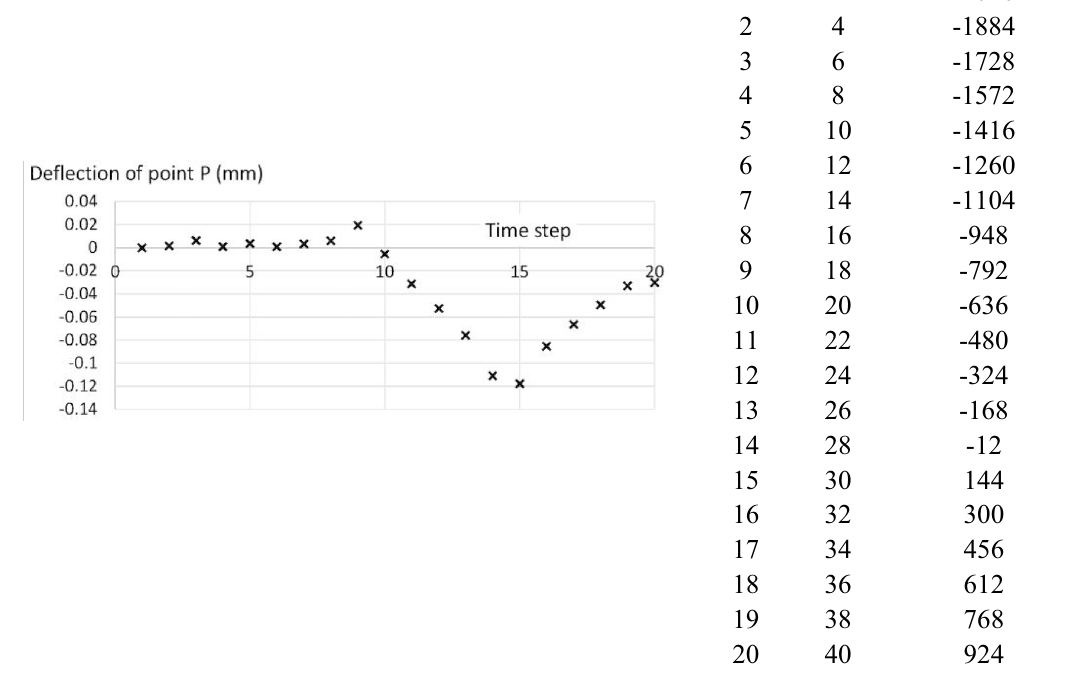
Figure 7. Variation with time of: (left) the deflection at point P; (right) the center point of the loaded area. The X axis is represented in Fig. 4.